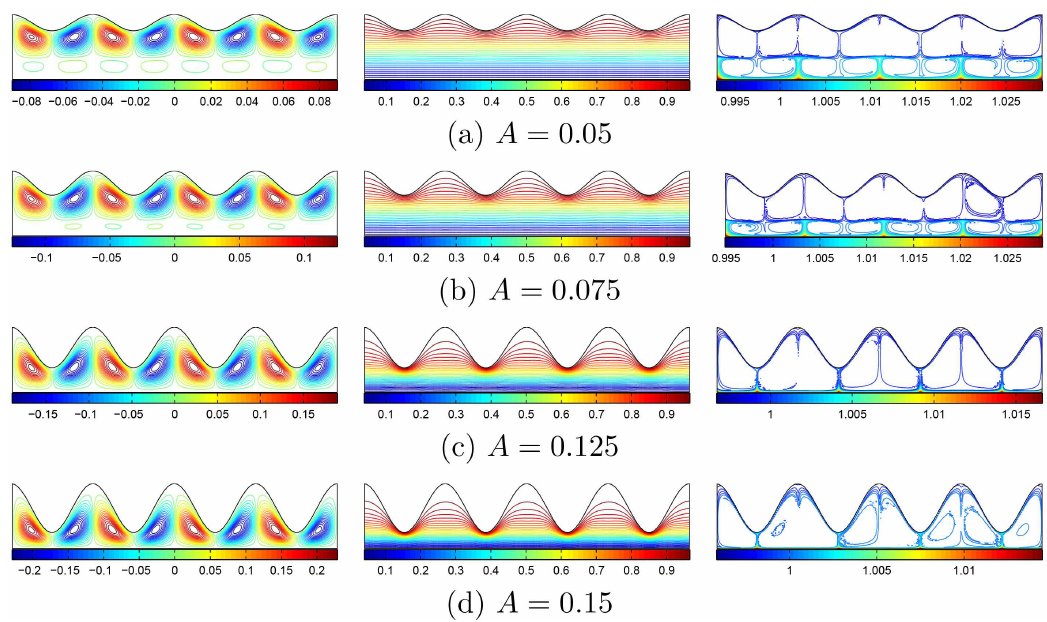
Figure 8. Variation of the streamlines ( left ), isotherms ( middle ), and nanoparticle distribution ( right ) evolution by amplitude ( A ) for N = 4, Ra = 10 6 , and φ = 0.02 in the plane ( X , Y